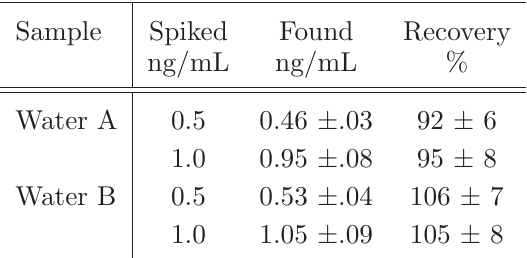
Table 4 Recovery of total arsenic at the addition of standards